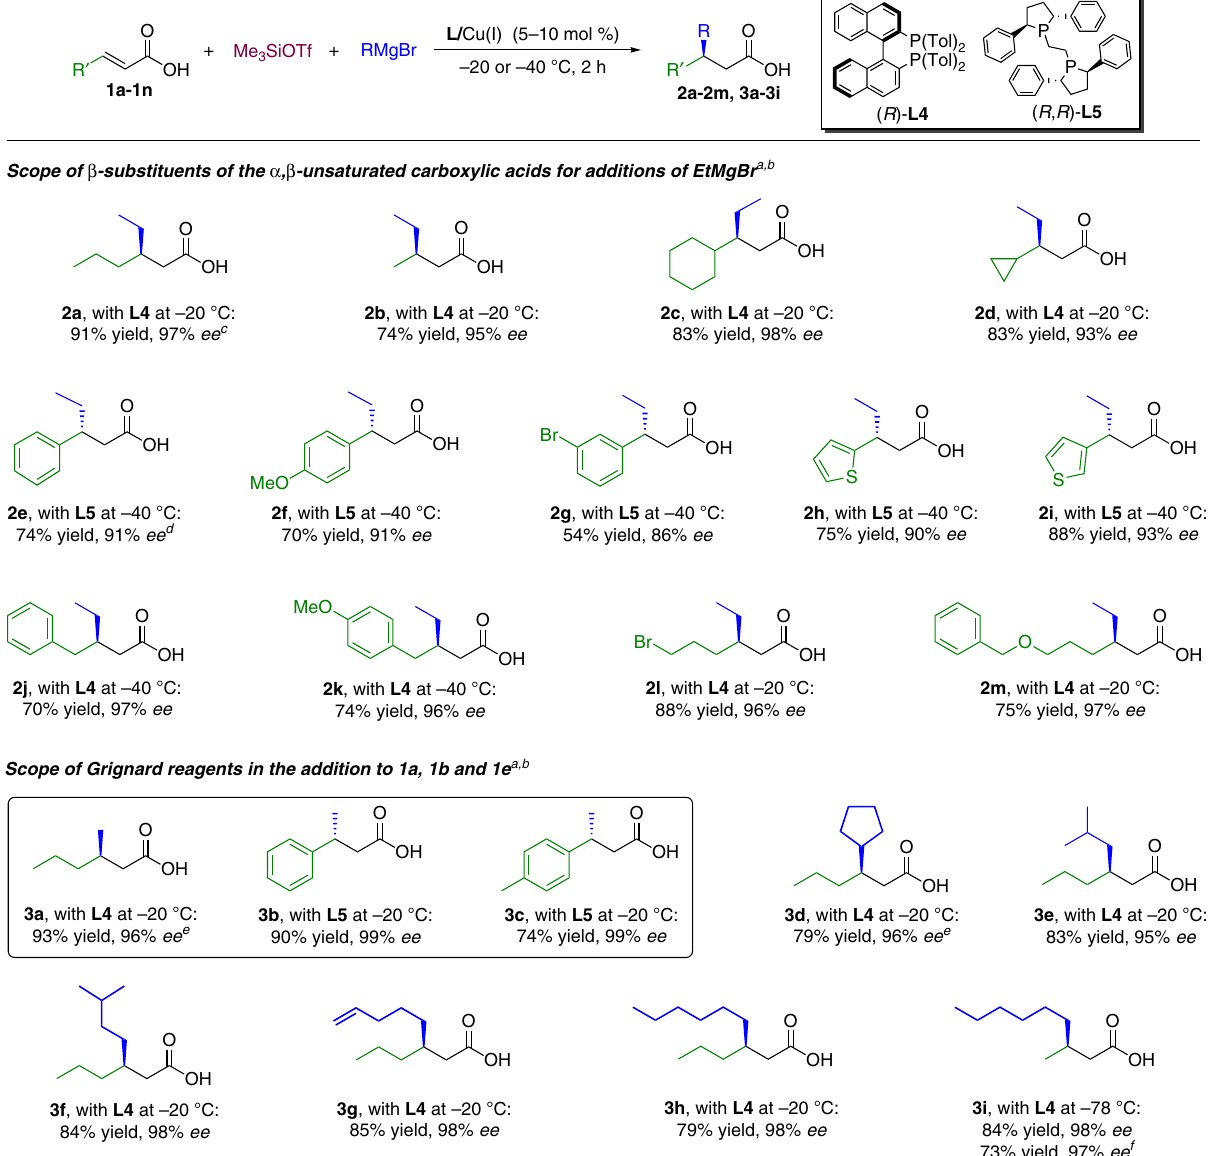
Fig. 4 Scope of the substrate and Grignard reagent. a For details see Supplementary Information. Isolated yields for all the products are shown. The absolute con fi guration of the products obtained with ( R )- L4 or ( R , R )- L5 as the ligands are opposite. b Reaction conditions: 0.1 M of the substrate in t BuOMe with 5 mol% ( R )- L4 /CuBr·SMe 2 or in t BuOMe/toluene = 1/1 with 10 mol% ( R , R )- L5 /CuBr·SMe 2 , 2 – 3 equiv. of Me 3 SiOTf and RMgBr. c Using 5 mol% ( R,R )- L5 / CuBr·SMe 2 as a catalyst in the same condition led to 1a with 93% ee . d Using 5 mol% ( R )- L4 /CuBr·SMe 2 as a catalyst led to 2e with 57% ee . e The reaction performed using 10 mol% of ( R )- L4 /CuBr·SMe 2 . f The reaction performed at − 40